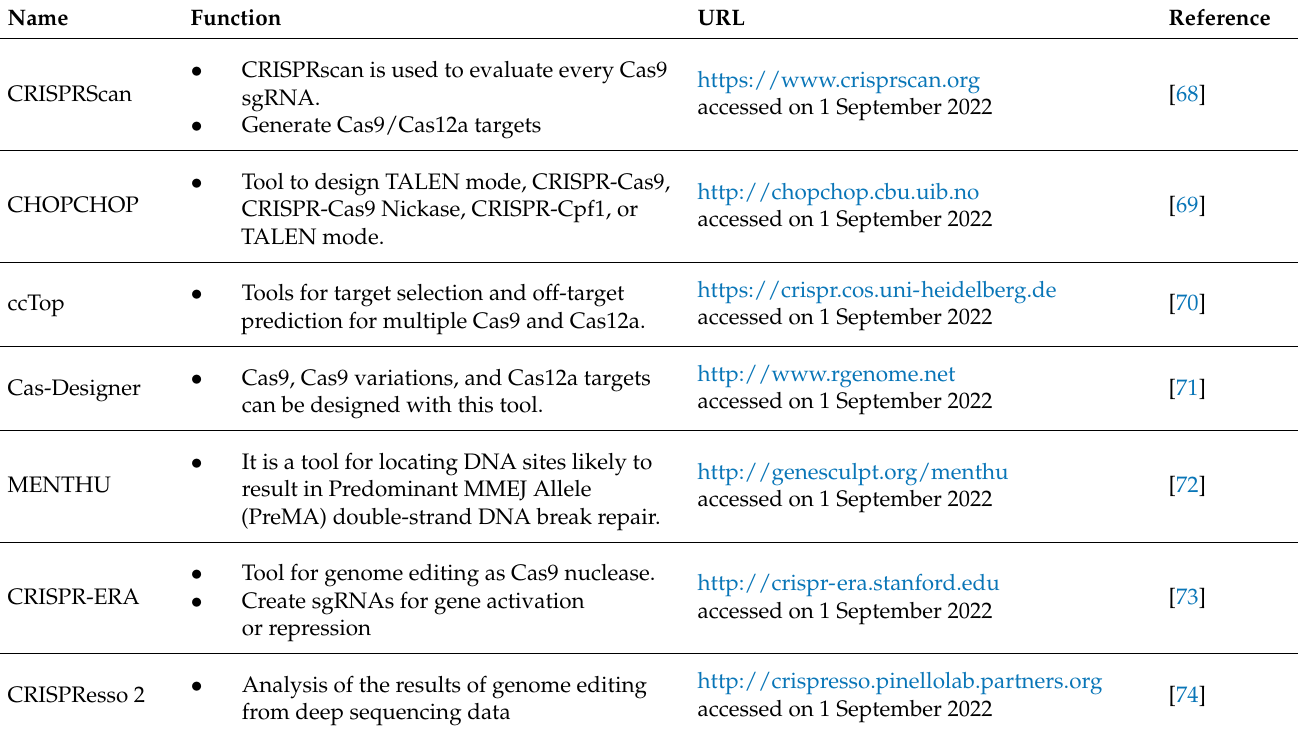
Table 1. CRISPR-Cas-related genome editing resources that may be appropriate for use in